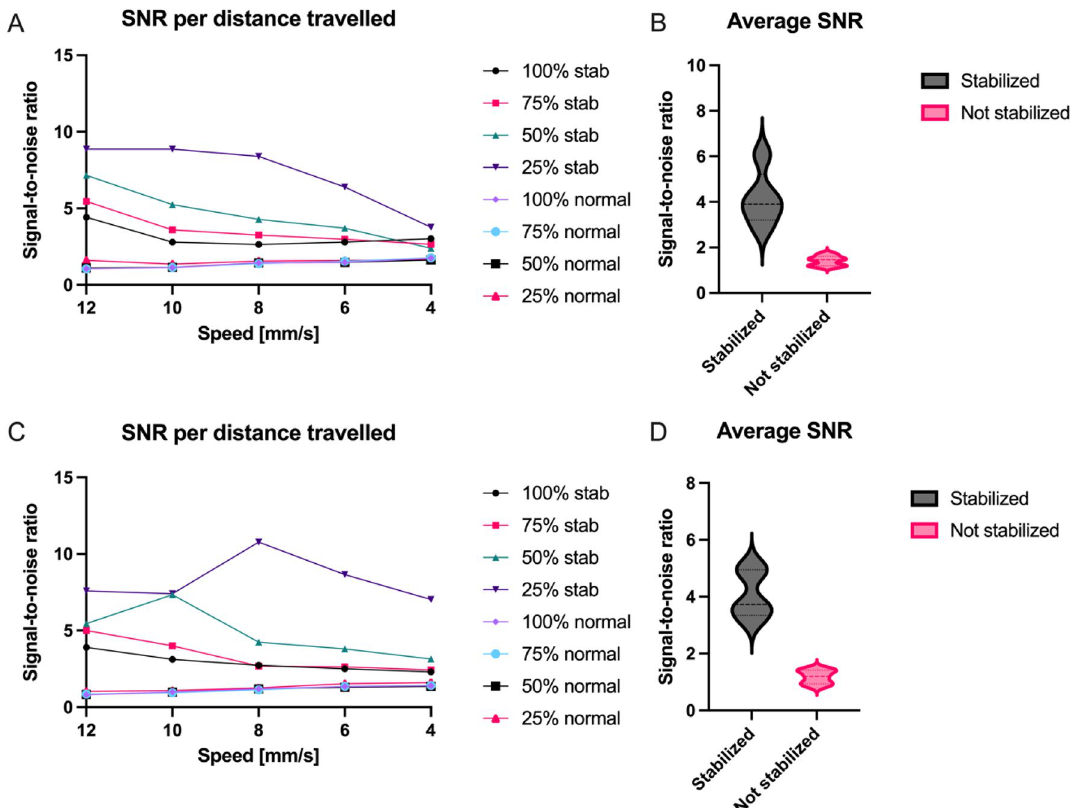
Figure 3. ( A ) Signal-to-noise ratio for each distance per movement speed in mm/s for the 20-cm camera distance. ( B ) Box-and-violin plots of average signal-to-noise ratios for the 20-cm camera distance. ( C ) Signal- to-noise ratio for each distance per movement speed in mm/s for the 9-cm camera distance. ( D ) Box-and-violin plots of average signal-to-noise ratios for the 9-cm camera